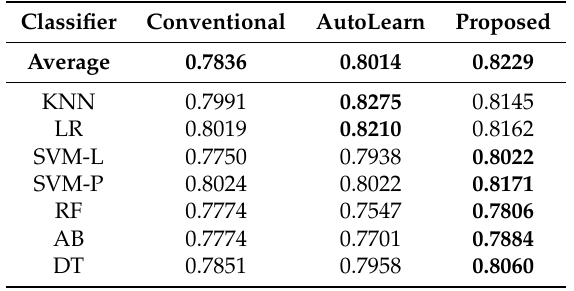
Table 5. Average classification accuracy for 13 test datasets.